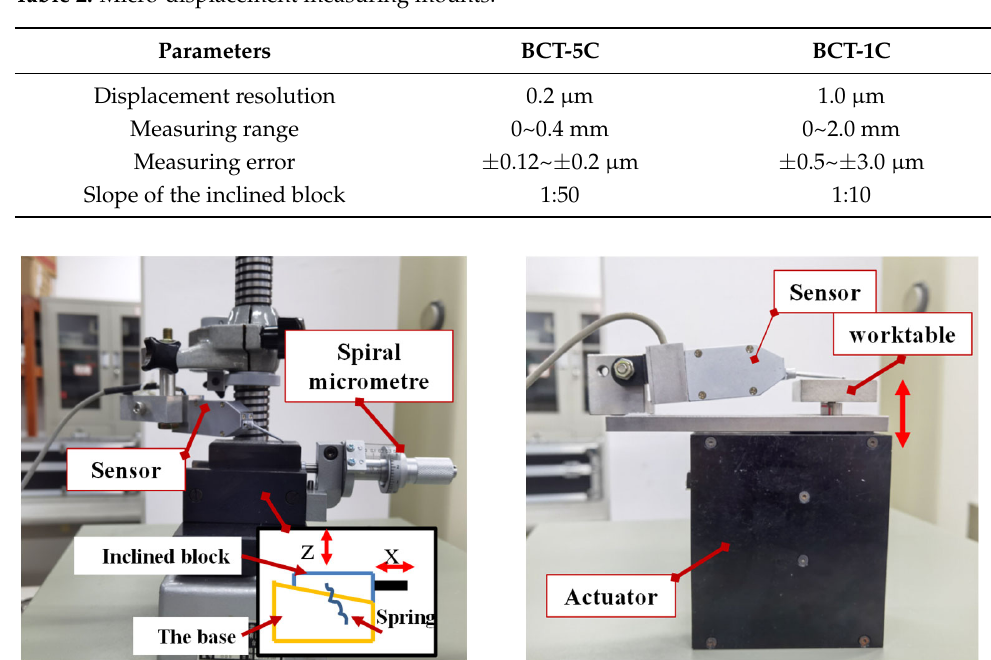
Figure 6. Experimental Section setup: ( a ) Experimental Section setup block diagram; ( b ) Picture of experiment setup. Table 2. Micro-displacement measuring mounts.